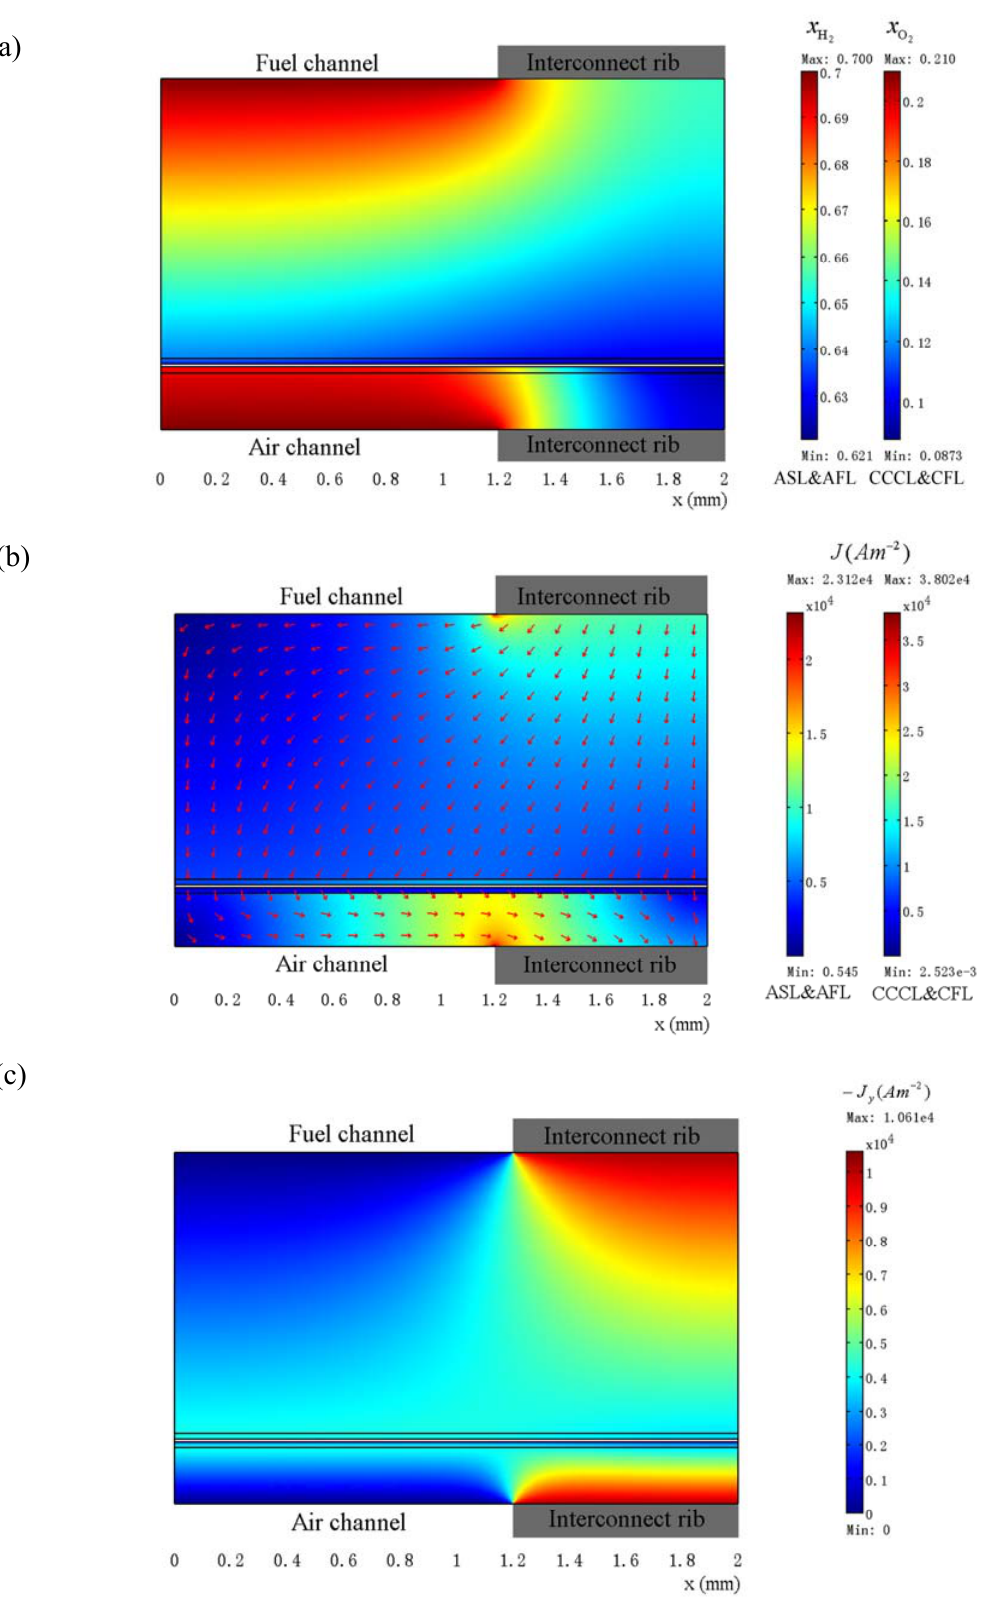
Figure 6. The distributions of physical quantities when the CCCL layer thickness is 200 μ m: (a) hydrogen and oxygen molar fractions; (b) total current density and current flux vector; (c) the y component of the current flux